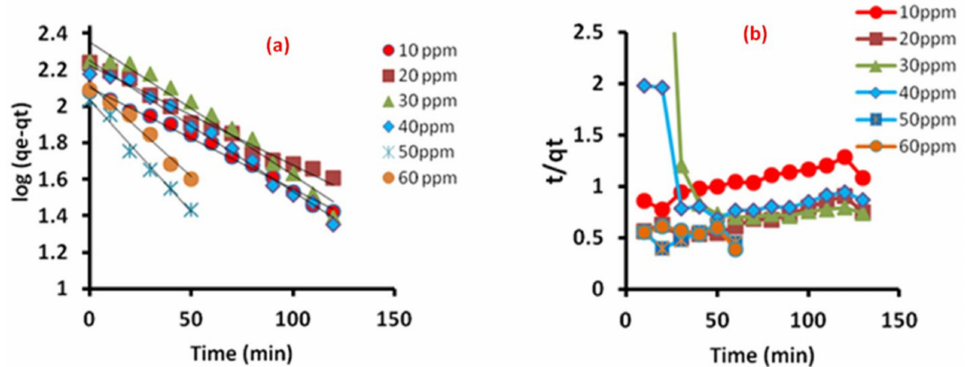
Figure 14. Kinetic study on dye adsorption of MB on HA/ Au. ( a ) Pseudo- first order and ( b ) pseudo- second-order kinetic model for dye adsorption of MB on HA/ Au [68].